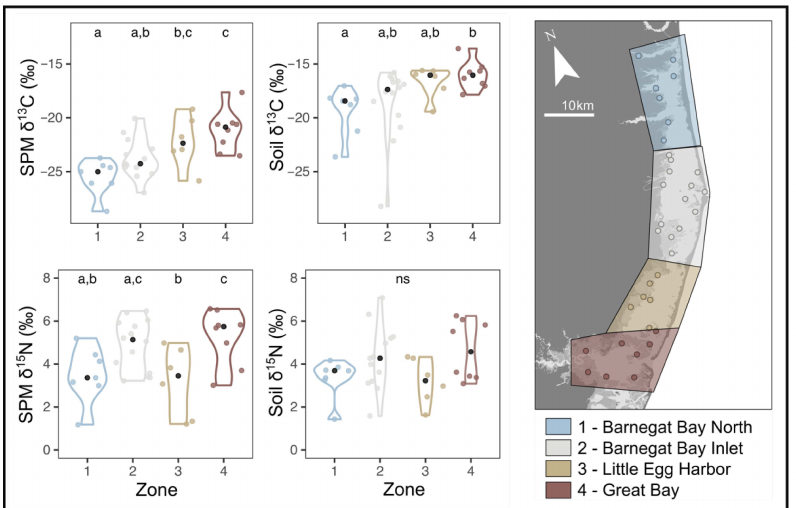
Figure 4. Distribution of suspended particulate matter (SPM) and salt marsh surface soil δ 13 C and δ 15 N across the four geographic zones that comprise the BB-LEH-GB. The map indicates sampling locations and zone boundaries. Letters within panels indicate differences between groups. For p -values and effect sizes, see Table S5.